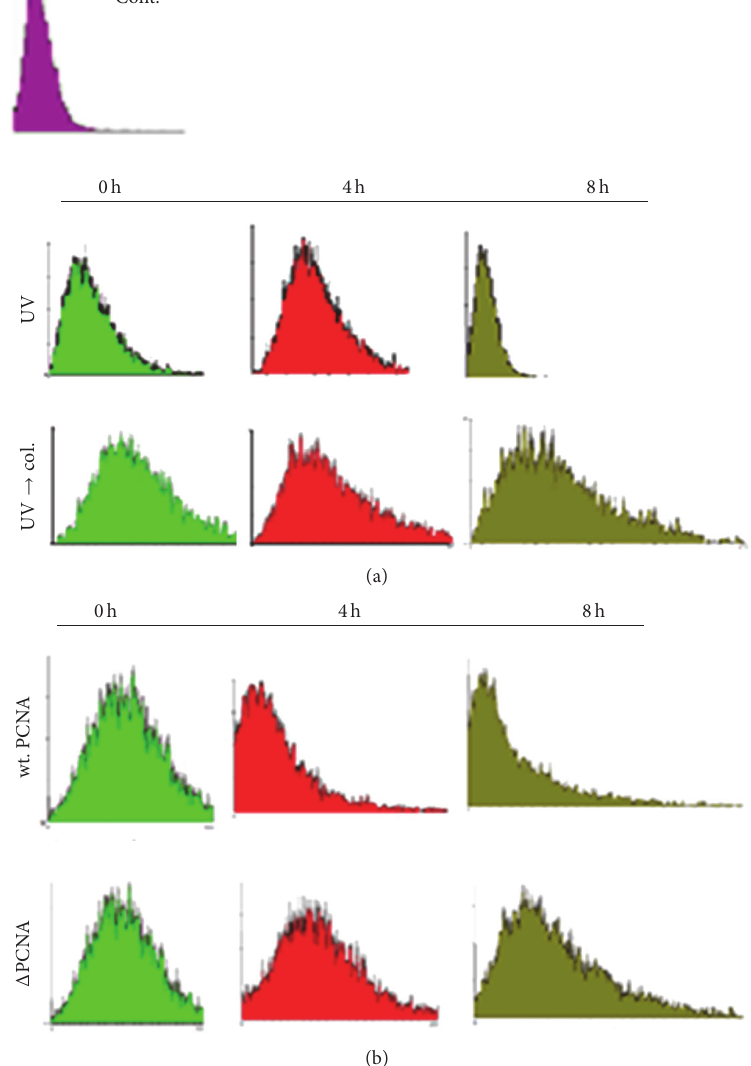
Figure 3: Flow cytometric analysis of nucleoid size. AGS cells were treated similarly as those described in Figure 1. (a) Cont. for control, that is, cells without treatment. UV and UV → col. for UV alone and UV then colcemid, respectively. Time points: 0–8 h after H/A removal. (b) Similar to (a), yet the cells were transiently transfected with the indicated expression plasmids. (Histogram: 𝑥 -axis: forward scattering; 𝑦 -axis: